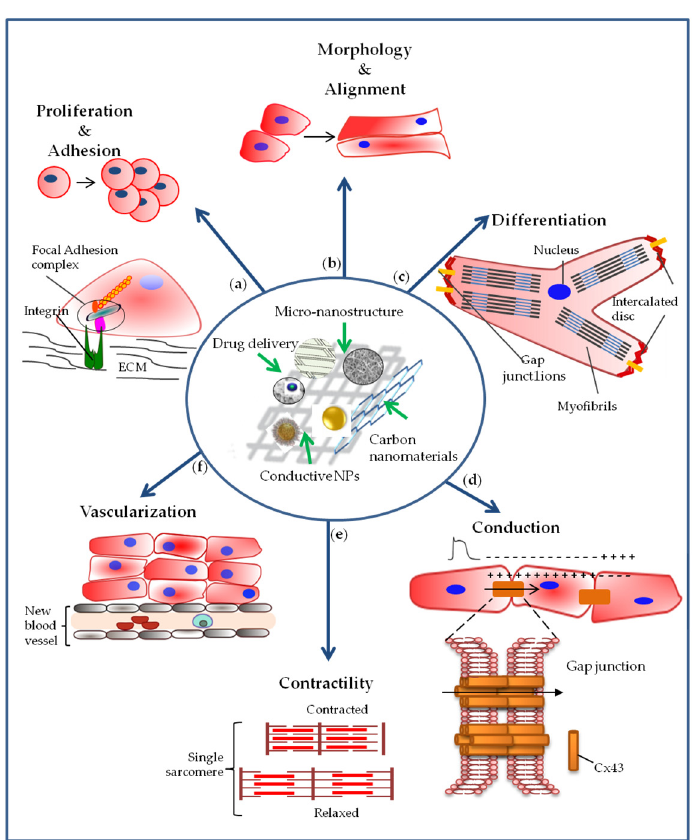
Figure 3. Representation of cellular effects required for myocardial regeneration, mediated by the interaction of stem cells and cardiac precursors with nanoengineered scaffolds. ( a ) The nanoengineered scaffolds can induce an increase in cell proliferation and adhesion ; ( b ) they can also influence cell morphology by directing cells towards greater alignment, and ( c ) stimulate cell differentiation toward cardiac lineage with the organization of sarcomeric proteins in sarcomeres; ( d ) they can increase the expression of connexin-43 involved in the intercellular junctions with effects on cellular electrical coupling and on impulse conduction. ( e ) Cell-cell communication mediated by gap junctions together with cell differentiation also allow cardiac tissue to contract. ( f ) The use of nanoengineered scaffolds must also stimulate the formation of new blood vessels since the supply of oxygen and nutrients are essential for both viability and function of the new cardiac tissue.